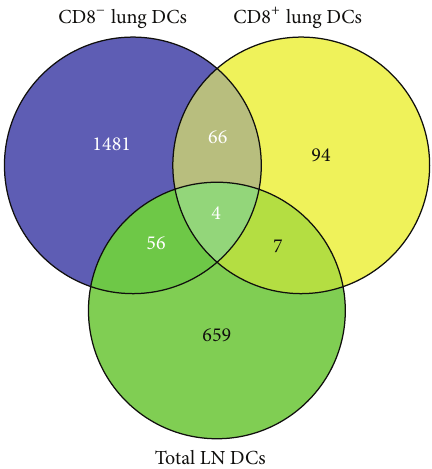
Figure 2: Venn diagram of regulated transcripts. The numbers and overlap of regulated transcripts ( > ± 2-fold) in the depicted DC subset from lungs and lung-draining lymph nodes derived from asthma versus control animals are shown,